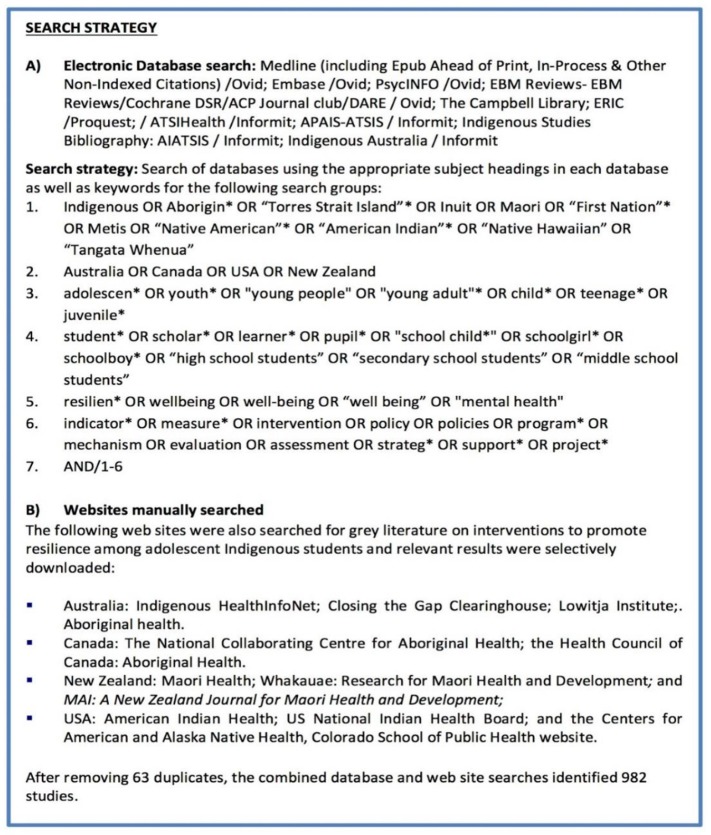
Search strategy.